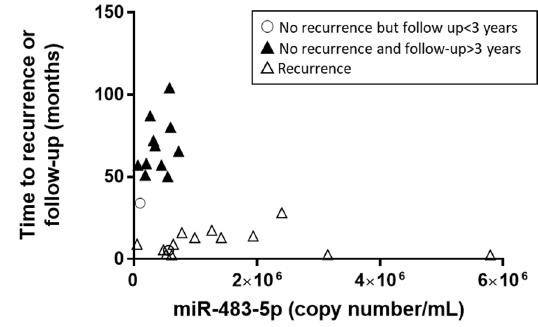
Figure 4. Time to recurrence or follow-up with no recurrence in function of miR-483-5p copy number.